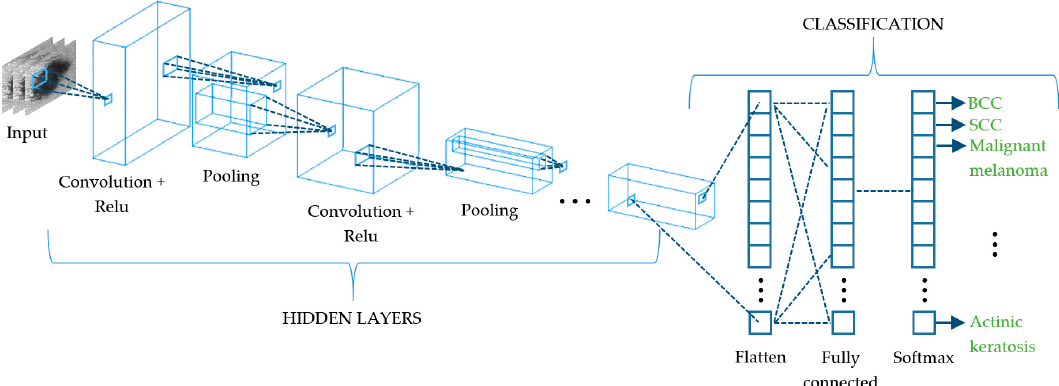
Figure 10. Schematic representation of a convolutional neural network (CNN) that extracts the different spatial characteristics of a skin cancer lesion at its subsequent layers.